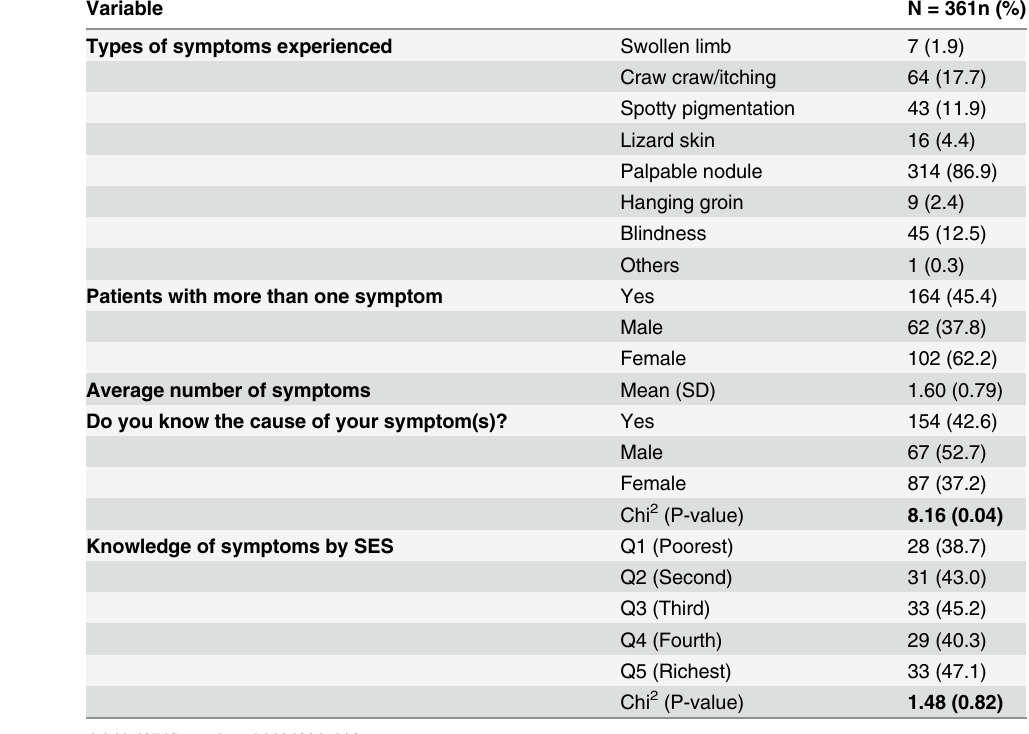
Table 2. Types of symptoms experienced and patient ’ s knowledge of